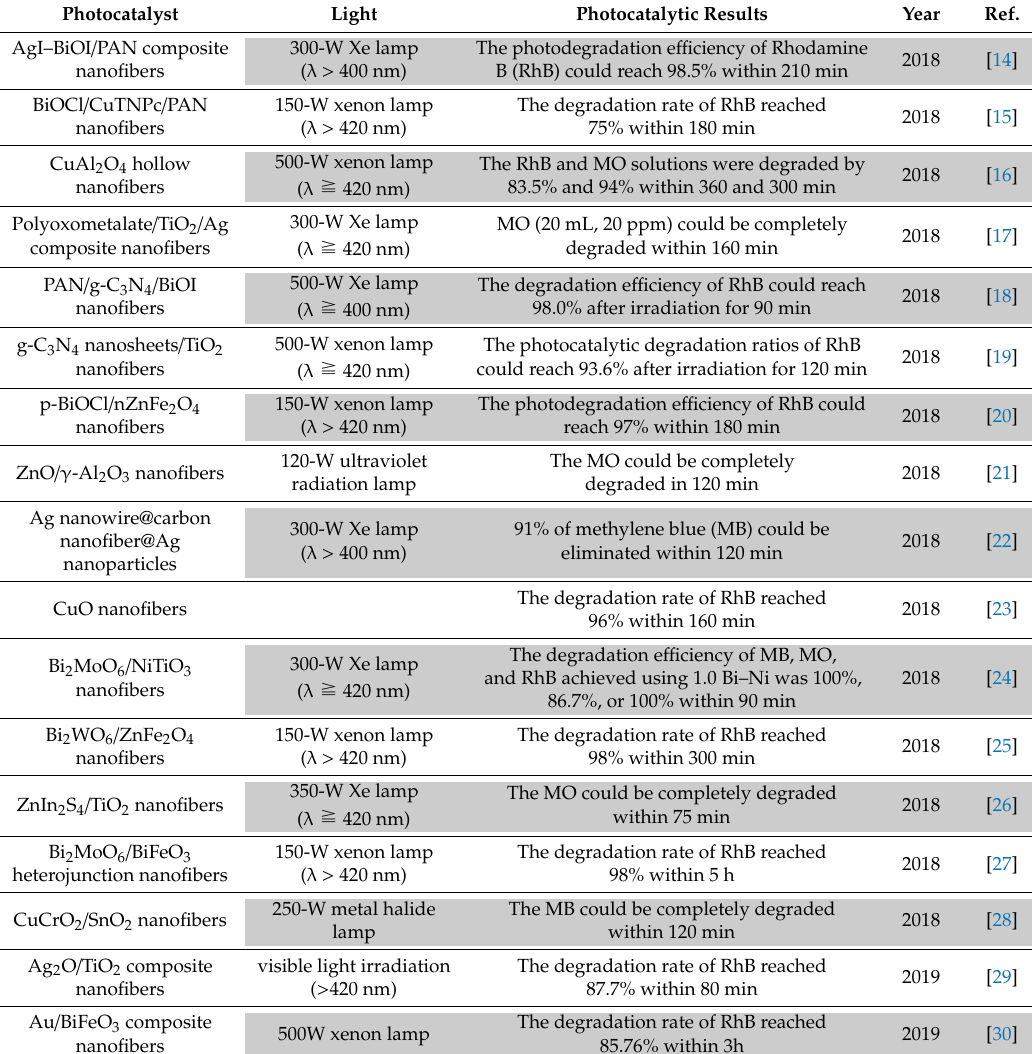
Figure 4. ( a ) Photocatalytic degradation curves and ( b ) the corresponding kinetic linear simulation curves of methyl orange (MO) over the different samples: (1) PAN nanofiber; (2) BiOBr/PAN CMs; (3) AgBr/BiOBr/PAN CMs-1; (4) AgBr/BiOBr/PAN CMs-2; (5) AgBr/BiOBr/PAN CMs-3; (6) AgBr/BiOBr/PAN CMs-4. C 0 : the initial concentration of MO; C: the residual concentration of MO. Table 1. The photocatalytic degradation parameters over the different nanofiber photocatalysts. Photocatalyst Light Photocatalytic Results Year Ref.